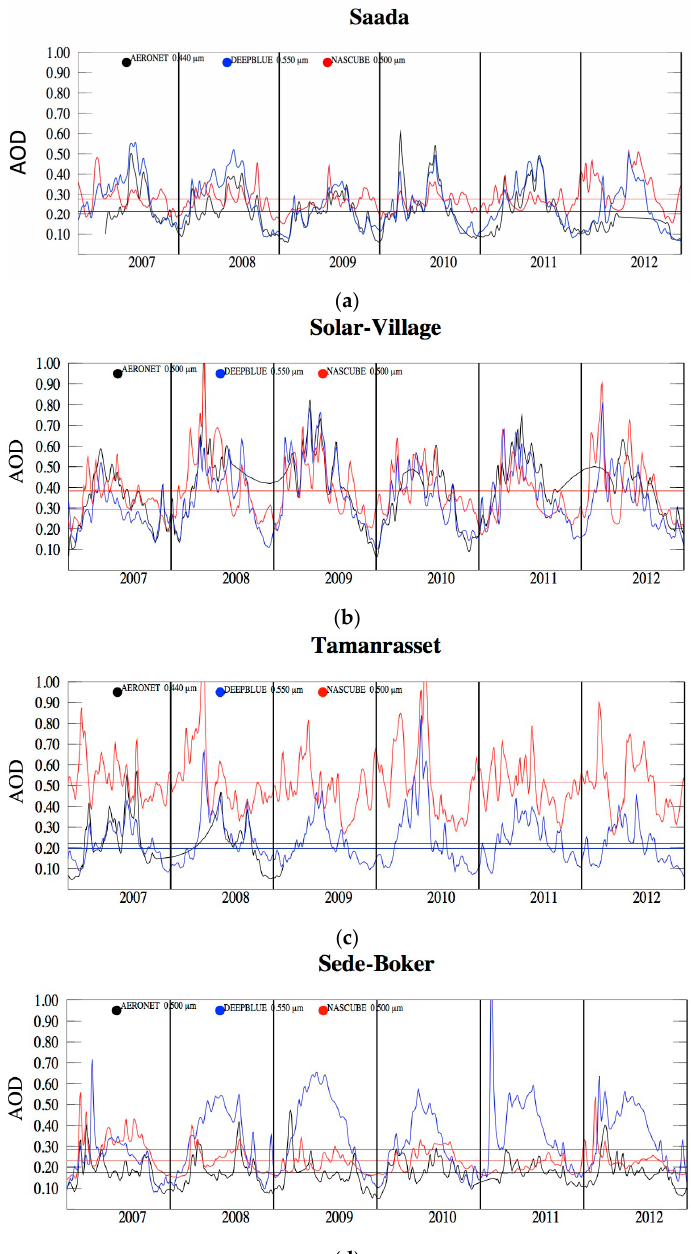
Figure 13. Time-evolutions of the AOD mean values at about 0.5 µm averaged over a week for the three instruments during 2007–2012 (AERONET in black, Deep Blue in blue, and NASCube in red). Four specific AERONET sites have been selected: ( a ) Saasa; ( b ) Solar Village; ( c ) Tamanrasset; ( d ) Sede-Boker. A Bezier function is applied to eliminate short time variations.